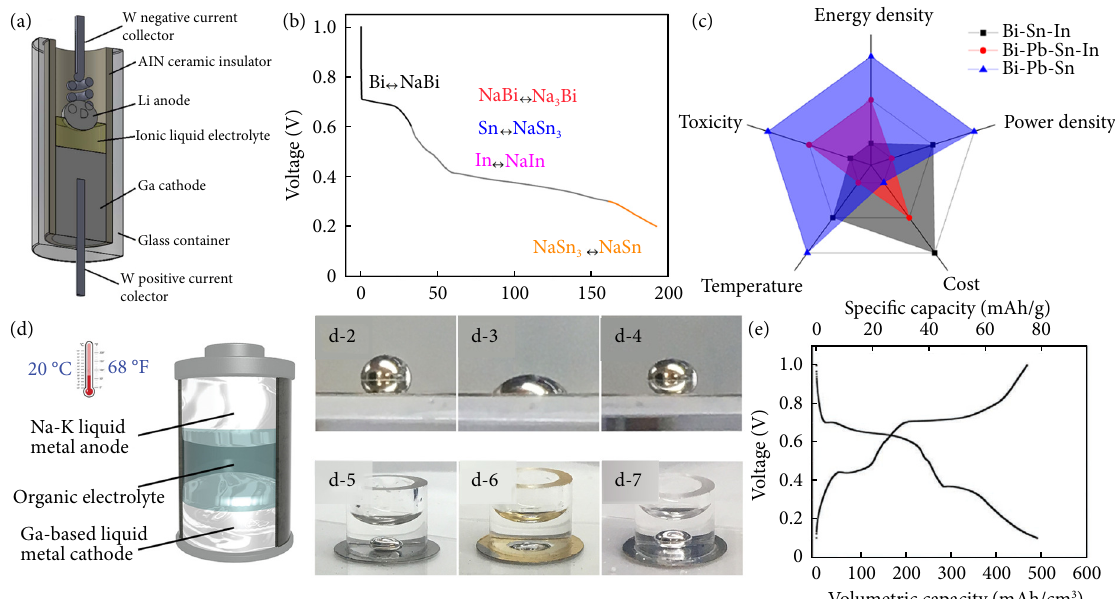
Fig. 12 (a) The configuration and discharge curves of Li||Ga LMB (10 mA cm-2). (b) Dischage profile of Bi–In–Sn vs Na at a specific current of 80 mA/g. (a,b) Reprinted with permission from ref. [137], © 2016 The Electrochemical Society. (c) The comparison of some low melting point liquid metal electrodes. Reprinted with permission from ref. [118], © 2020 American Chemical Society. (d-1) Configuration of the room temperature Na–K||Ga–In LMB. The wettability test of Ga–In alloys on the surface of different substrates in the air or Na electrolyte: stainless steel (d-2, d-5) , Au-coated stainless steel (d-3,d-6) , and Al-coated stainless steel (d-4,d-7) . (e) The charge-discharge curve of the Na–K||Ga–In LMB. (d,e) Reprinted with permission from ref. [119], © 2020